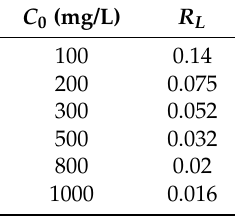
Table 3. Langmuir equilibrium constants RL at various initial concentrations.